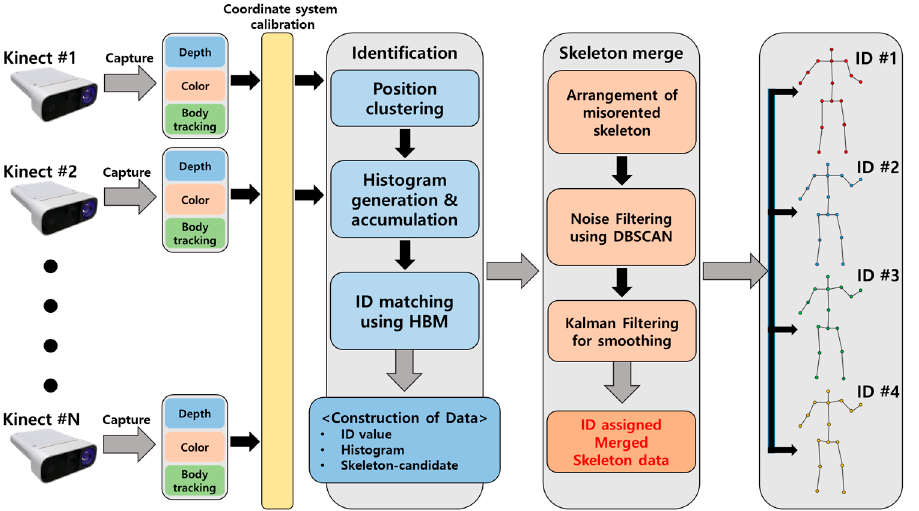
Figure 3. Overview of the multi-subject skeletal-tracking system.